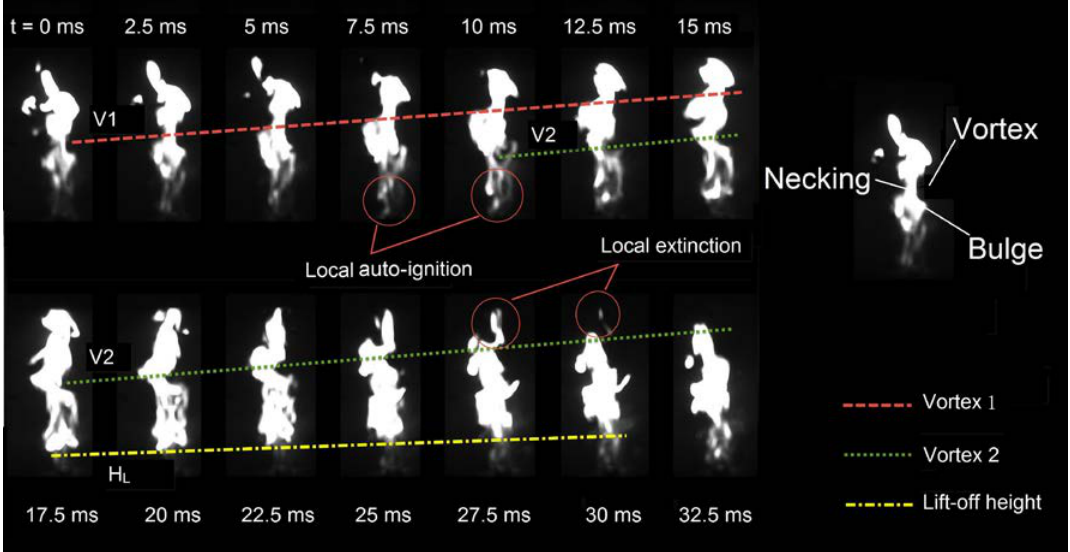
Figure 4. A sequence of continuous images for a typical condition.